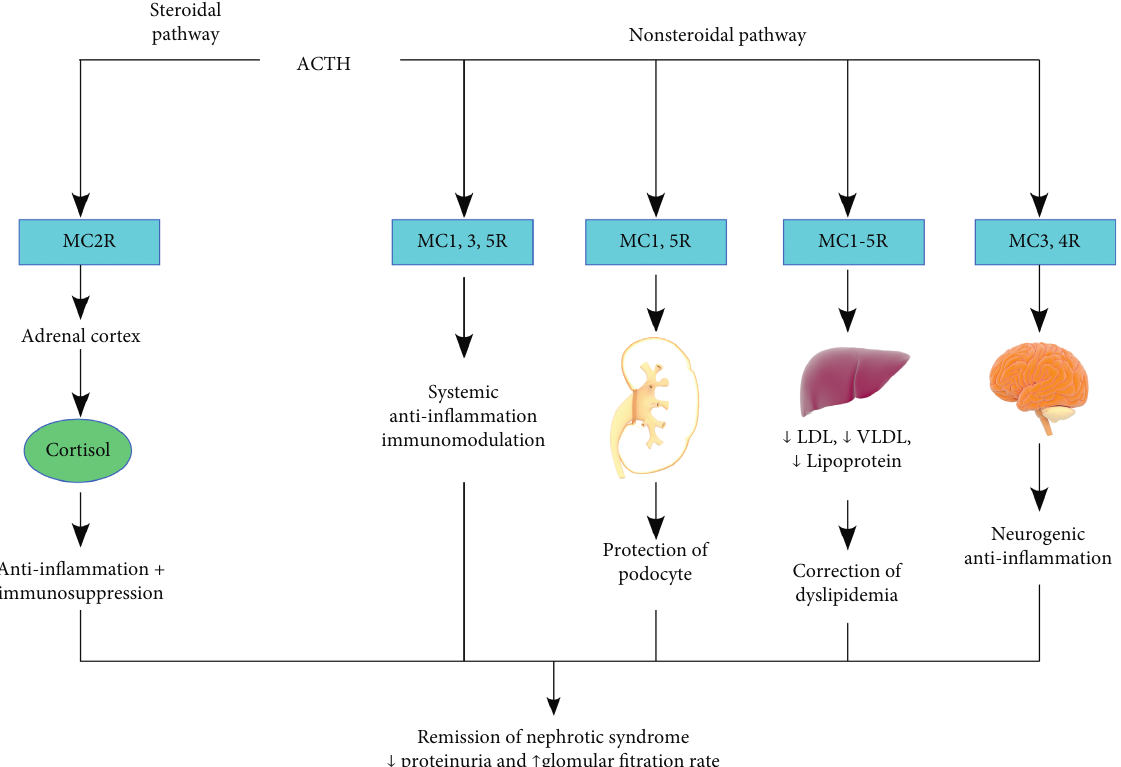
Figure 1: ACTH as a melanocortin receptor antagonist. Adapted from Gong [9].